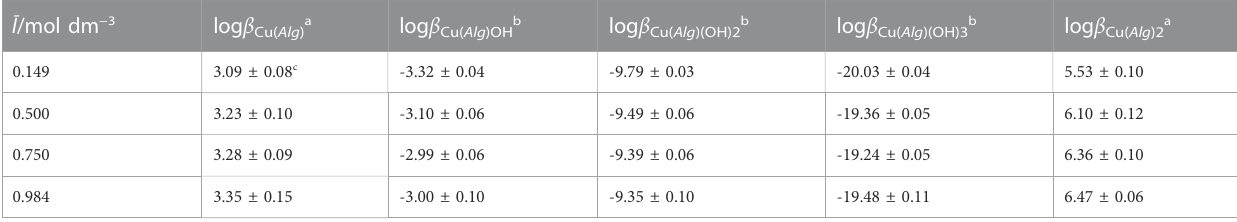
TABLE 4 Experimental overall formation constant of Cu 2+ / Alg 2- species at different ionic strengths in NaCl (aq) and T =